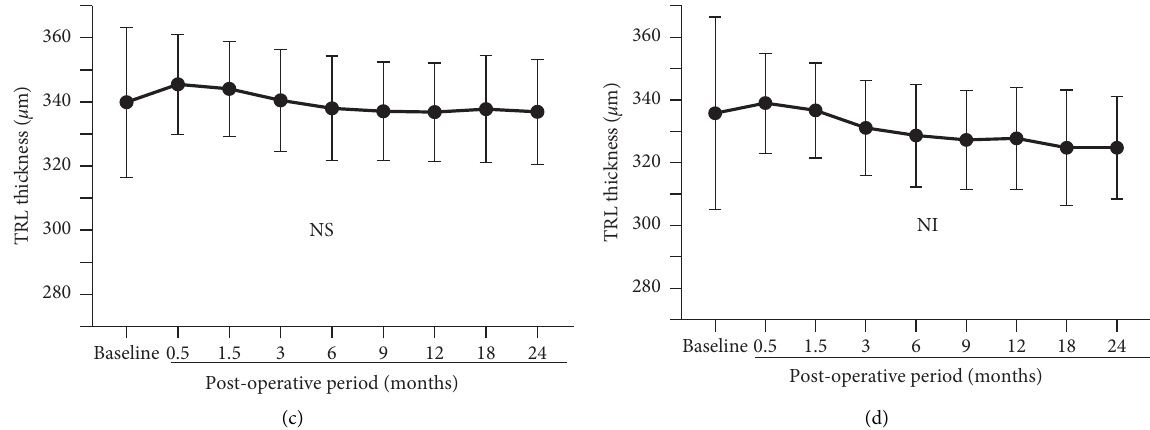
Figure 3: Mean thicknesses of the total retinal layer (TRL) are plotted for the MH eyes that had undergone vitrectomy with ILM peeling. In the temporal/superior (a) and temporal/inferior (b) quadrants, the TRL thickness decreases significantly with postoperative time. A significant thinning of the TRL was found between the baseline (preoperative eyes) and postoperative eyes at 3 months and thereafter. MH, macular hole; ILM, internal limiting membrane; TS, temporal/superior; TI, temporal/inferior; NS, nasal/superior; NI, nasal/inferior. Asterisks represent significant differences between the control and operated eyes. ∗∗ P < 0 . 005, ∗∗∗ P < 0 .